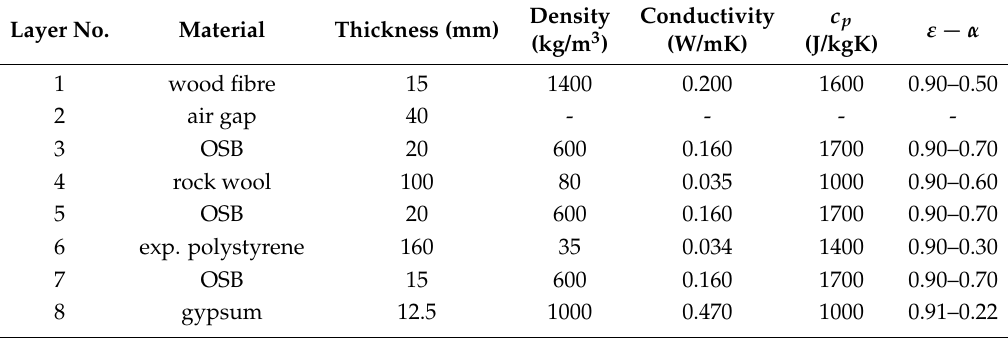
Table A3. Case C: light wall with 8 layers, “PL1” (Layer 1 is outdoors). Thickness: 382 mm. Layer No.